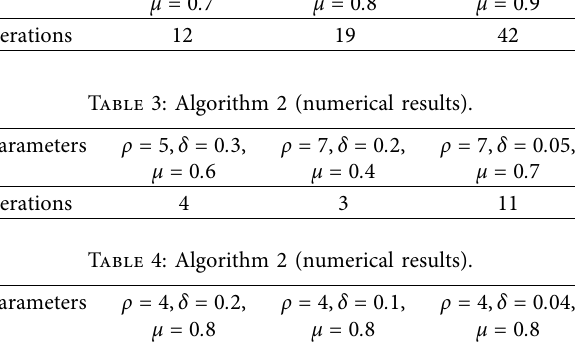
Table 2: Algorithm 2 (numerical results). Parameters